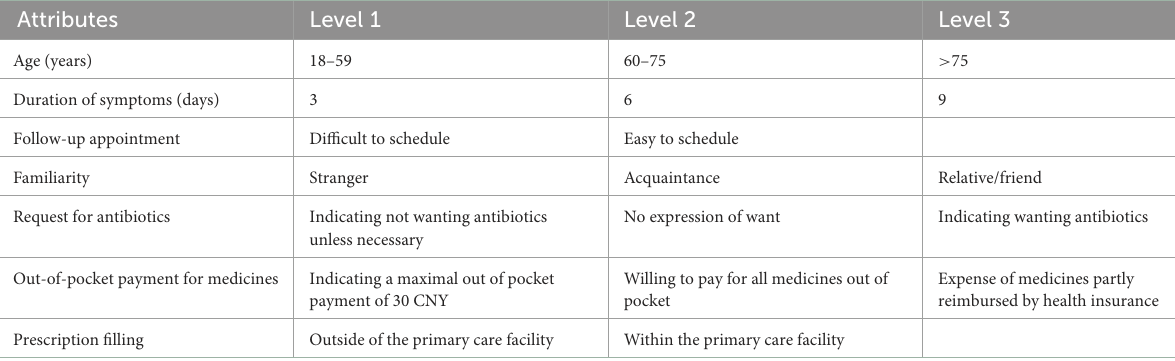
TABLE 2 Design of patient attributes and corresponding levels for the discrete choice